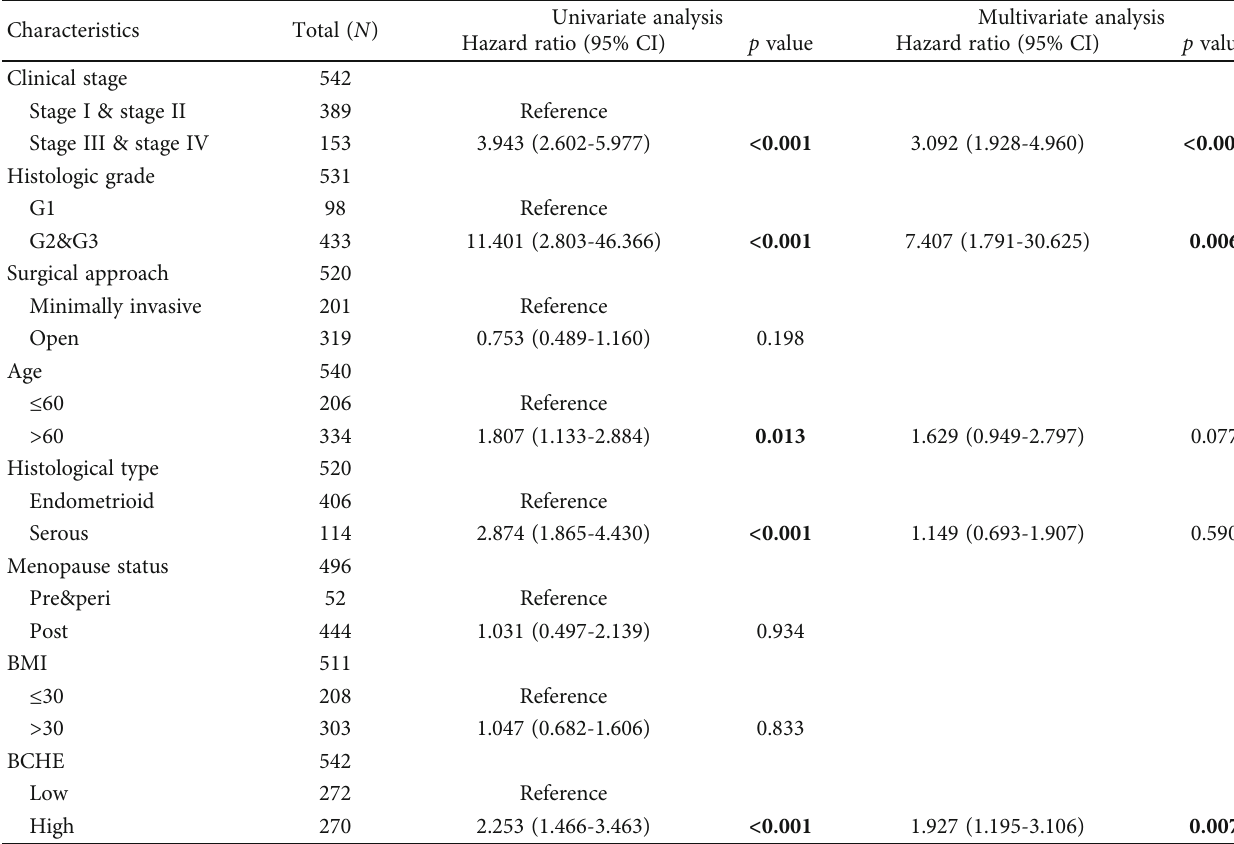
Table 2: Correlation between overall survival and multivariable characteristics in TCGA patients via Cox regression analyses.